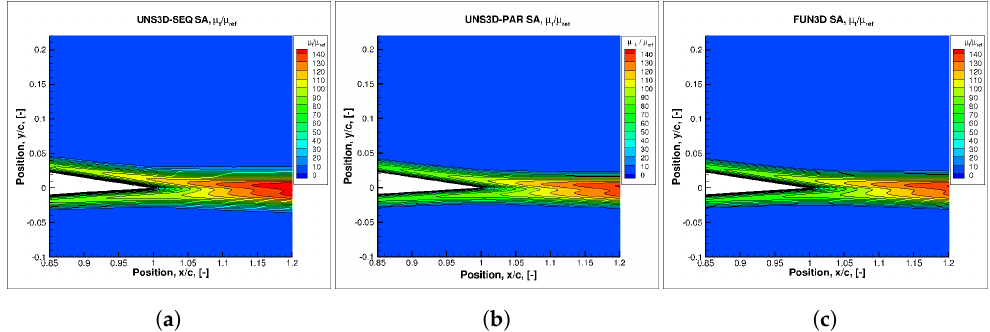
Figure 12. µ t / µ ∞ contours on Nakayama’s airfoil predicted with Spalart–Allmaras model: ( a ) UNS3D-SEQ, ( b ) UNS3D-PAR, and ( c ) FUN3D.